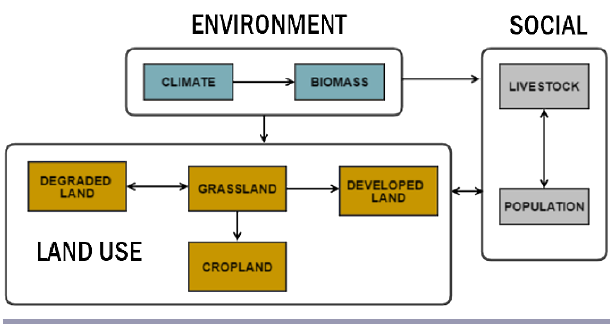
Fig. 3 . Conceptual diagram of the system dynamics